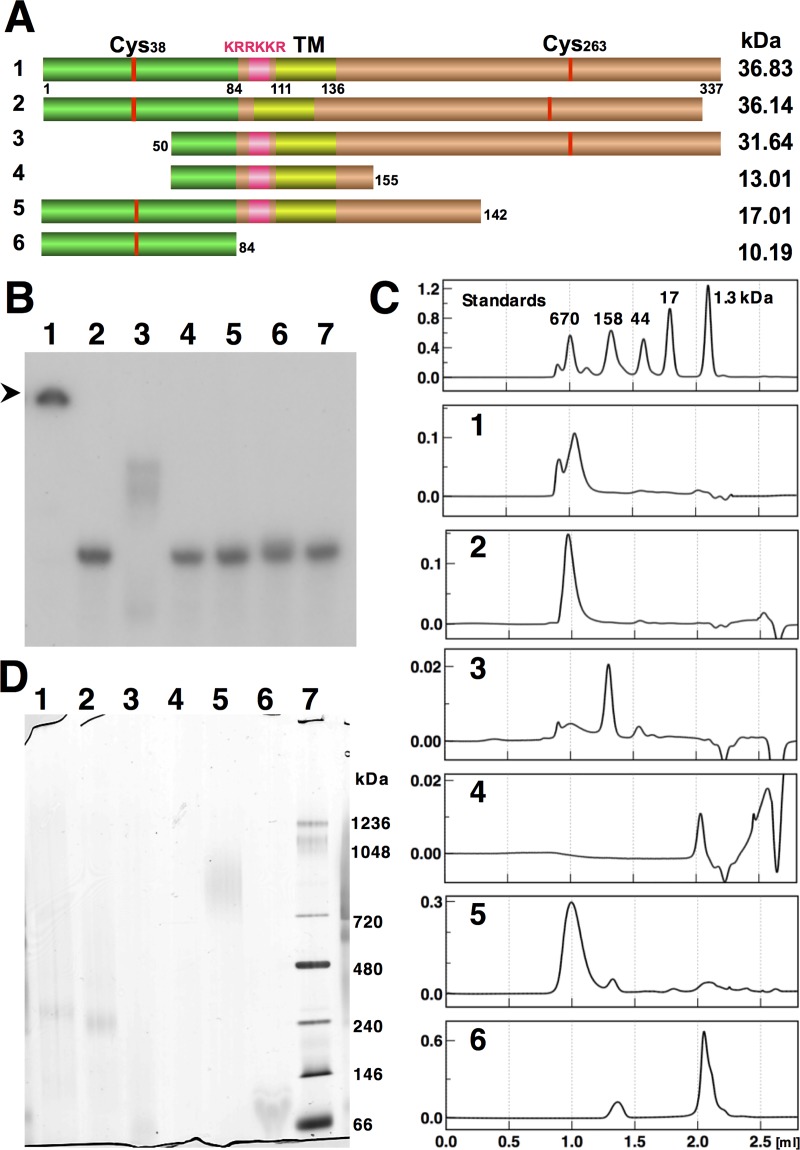
Functional mapping of the RNA-binding domain and multimerization of RodZ.The numbers indicating the RodZ variants are as follows: 1, RodZwt; 2, RodZΔKRRKKR; 3, RodZ50-337; 4, RodZ50-155; 5, RodZ1-142; 6, RodZ1-84. (A) RodZ domains and deletion constructs: green, cytosolic; pink, KRRKKR; yellow, transmembrane; ocher, periplasmic domain; red, cysteine residues. Calculated molecular weights of the -his6 fusion proteins are indicated on the right side of the panel. (B) RNA binding activities of the indicated deletion proteins determined using EMS analysis. Lane 7: RNA probe without protein. Arrowhead indicates bottom of gell wells. (C) Gel filtration analysis of the deletion proteins. Standards: Elution profile of the molecular-weight standards is identical to that shown in Fig 1A. (D) BN-PAGE analysis of the deletion proteins. Lane 7: Molecular mass markers.